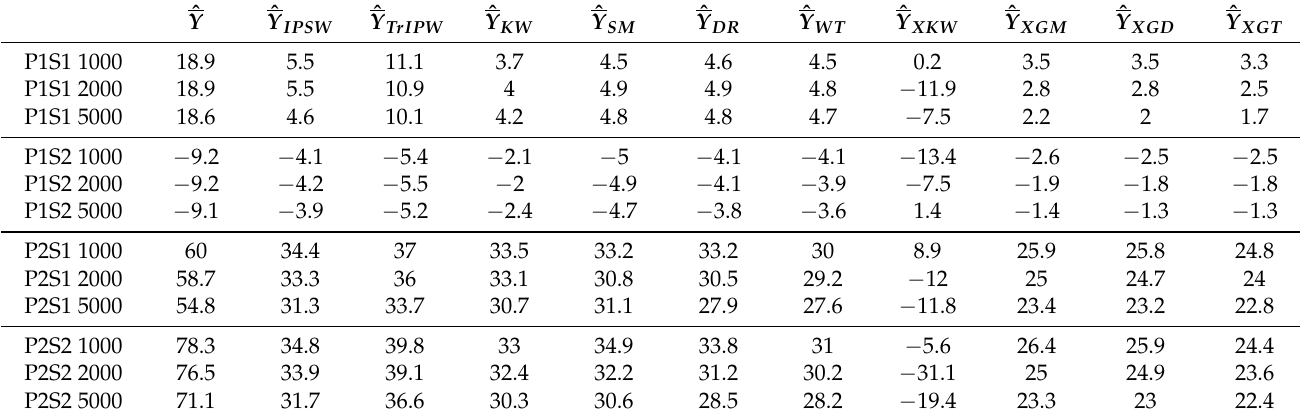
Table 1. Relative bias (%) for each real population case.